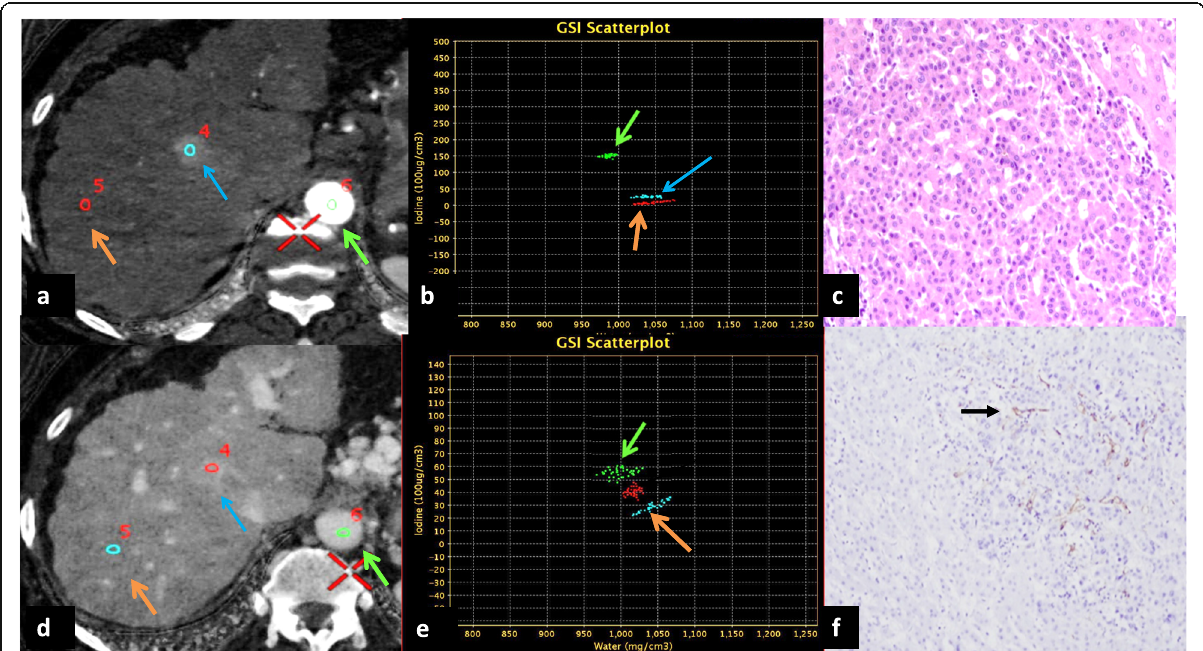
Fig. 6 Spectral computed tomography-based material density (MD) map (iodine only image) and scatter plots with histopathological confirmation of an indeterminate nodule. a Axial MD map on HAP depicting indeterminate nodule with ROI (blue circle) placed at its centre (blue arrow), ROI (red circle) placed on the background liver parenchyma (orange arrow) and ROI (green circle) within the aorta at the same level (green arrow). b Scatter plot demonstrating ICD nodule HAP for nodule (blue arrow) more than the background liver ICD liver HAP (orange arrow) and less than ICD aorta (green arrow) as reference. c Histopathology confirmation of nodule, showing features of high-grade dysplasia. d Axial MD map acquired on PVP showing ROI (red circle) placed in the centre of the nodule (blue arrow), ROI (blue circle) on the liver parenchyma (orange arrow), and aorta (green circle) at the same level (green arrow). e Scatter plot demonstrating ICD nodule PVP (blue arrow) persistently higher than ICD liver PVP (orange arrow). f Immunohistochemistry slide showing CD34-positive foci (black bold arrow) in the nodule depicting